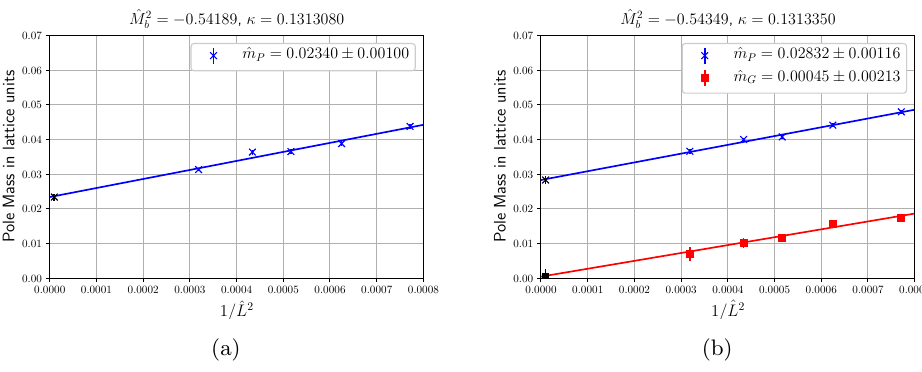
Figure 2 . Examples of the in(cid:12)nite-volume extrapolation for the pole mass in the symmetric (a) and the broken (b) phases using the ansatz of eq. (3.18). Results for the Goldstone-boson mass, computed from the average for the propagators of the three Goldstone modes, in the broken phase are also shown in